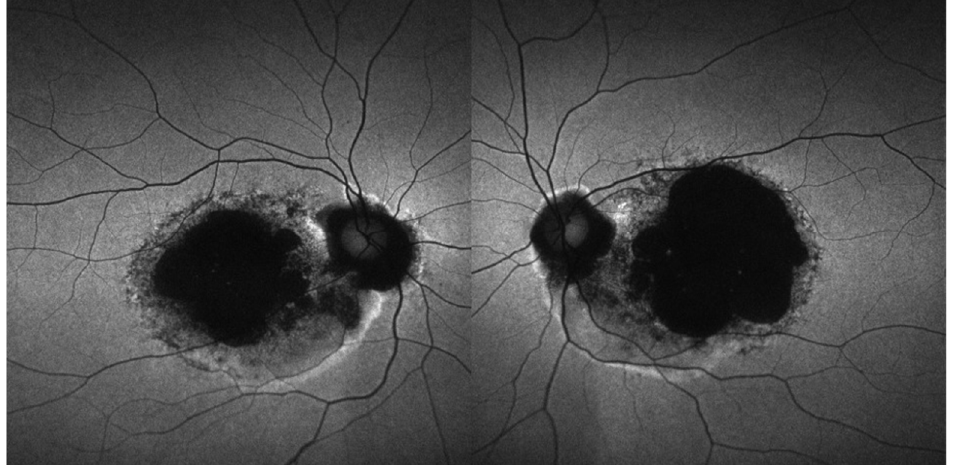
Figure 4. FAF images of the right and left eyes of the patient with early onset CRD harboring a novel homozygous c.143C > A (p.Thr48Asn) CDHR1 variant. The panel shows coalescence of hypoauto- fluorescence with surrounding areas of irregular hyperautofluorescence in the macular area bilat- erally. FAF, fundus autofluorescence; CRD, cone–rod dystrophy.